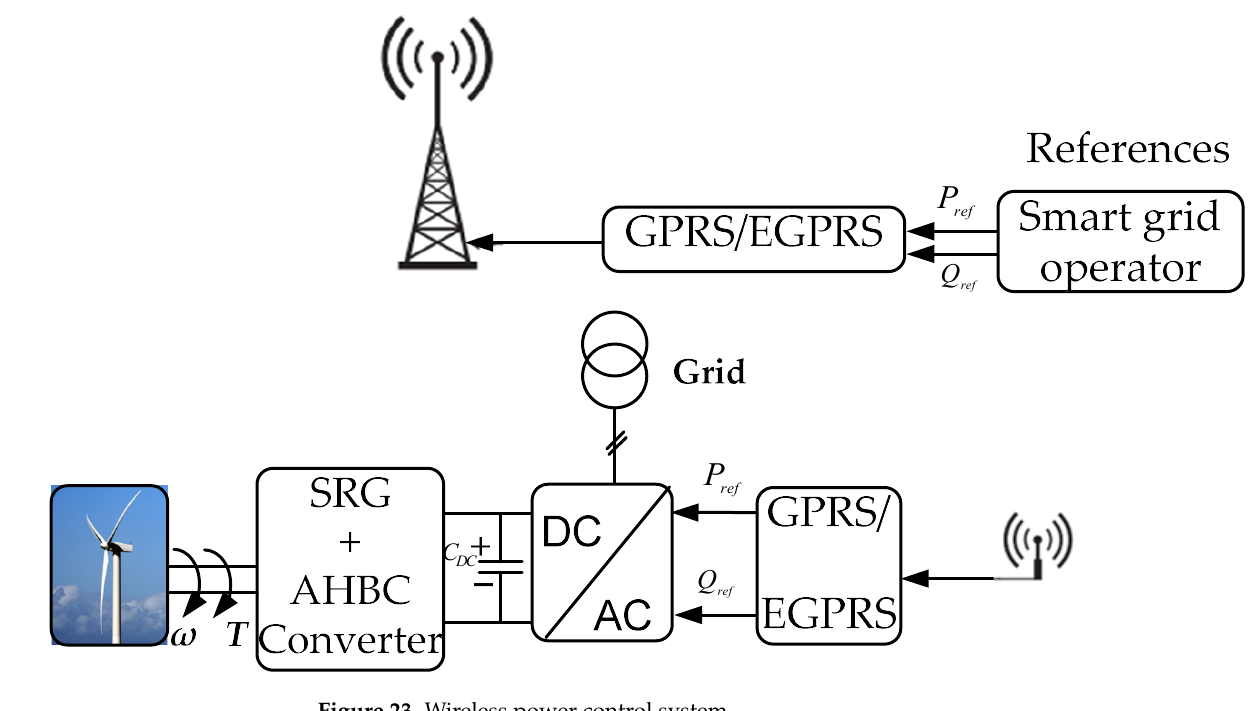
Figure 23. Wireless power control system.